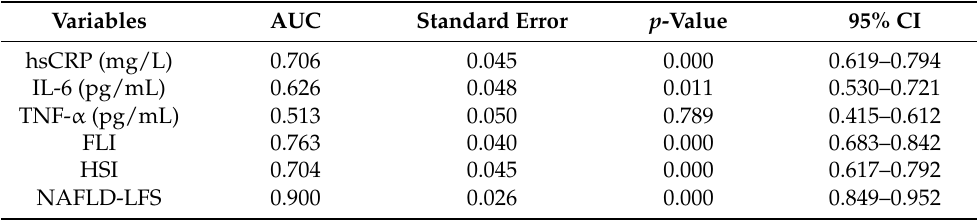
Table 2. The predictive value of inflammatory markers and hepatic steatosis markers.